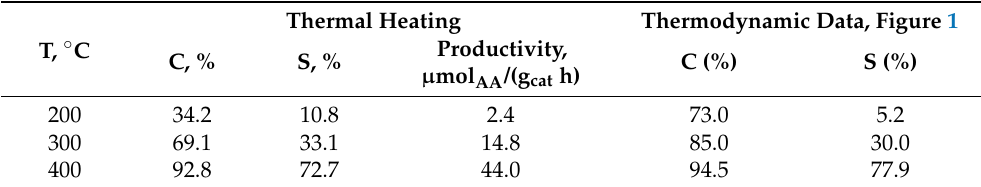
Table 2. Ethanol conversion (C) and selectivity to acetaldehyde (S) over the unmodified ZnO–CuO– SiO 2 catalyst and the thermodynamic data for different reaction temperatures. Thermal Heating Thermodynamic Data, Figure T, ◦ C